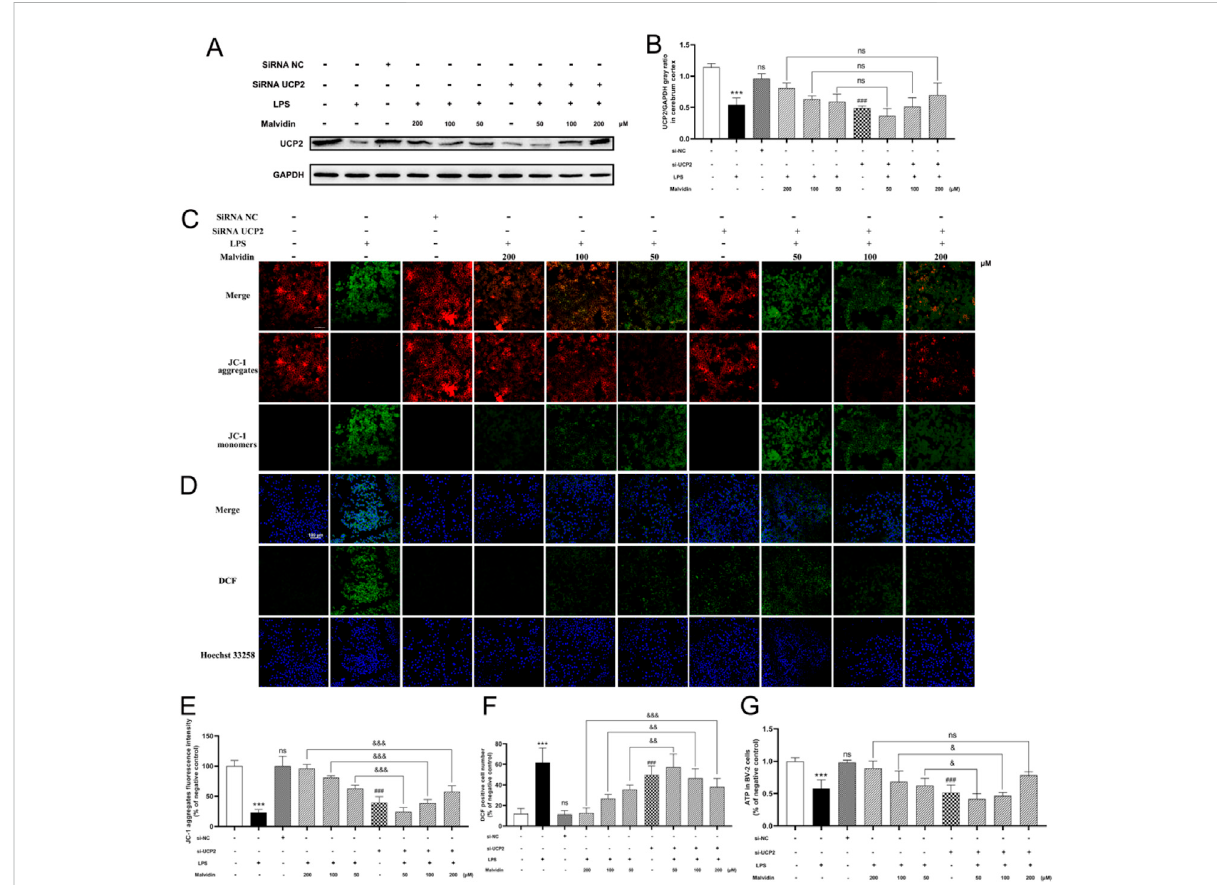
Inhibition of UCP2 on MMP changes, ATP production, and ROS release in malvidin pretreated LPS stimulated BV-2 cells. BV-2 cells were transfected with si-UCP2 to inhibit UCP2 protein expression. (A) UCP2 protein expression levels in BV-2 cells were detected using immunoblotting assays. GAPDH was used as an internal reference. (B) Gray ratio analysis of UCP2/GAPDH in (A) using ImageJ and excel software ( n = 3). (C,E) LSCM observation of JC-1 aggregates fl uorescence signals (red) and monomers fl uorescence signals (green) in BV-2 cells. The fl uorescence density of JC-1 aggregates were analyzed using ImageJ software ( n = 3). (D,F) ROS levels were detected in BV-2 cells using ROS assay kit with fl uorescent probe